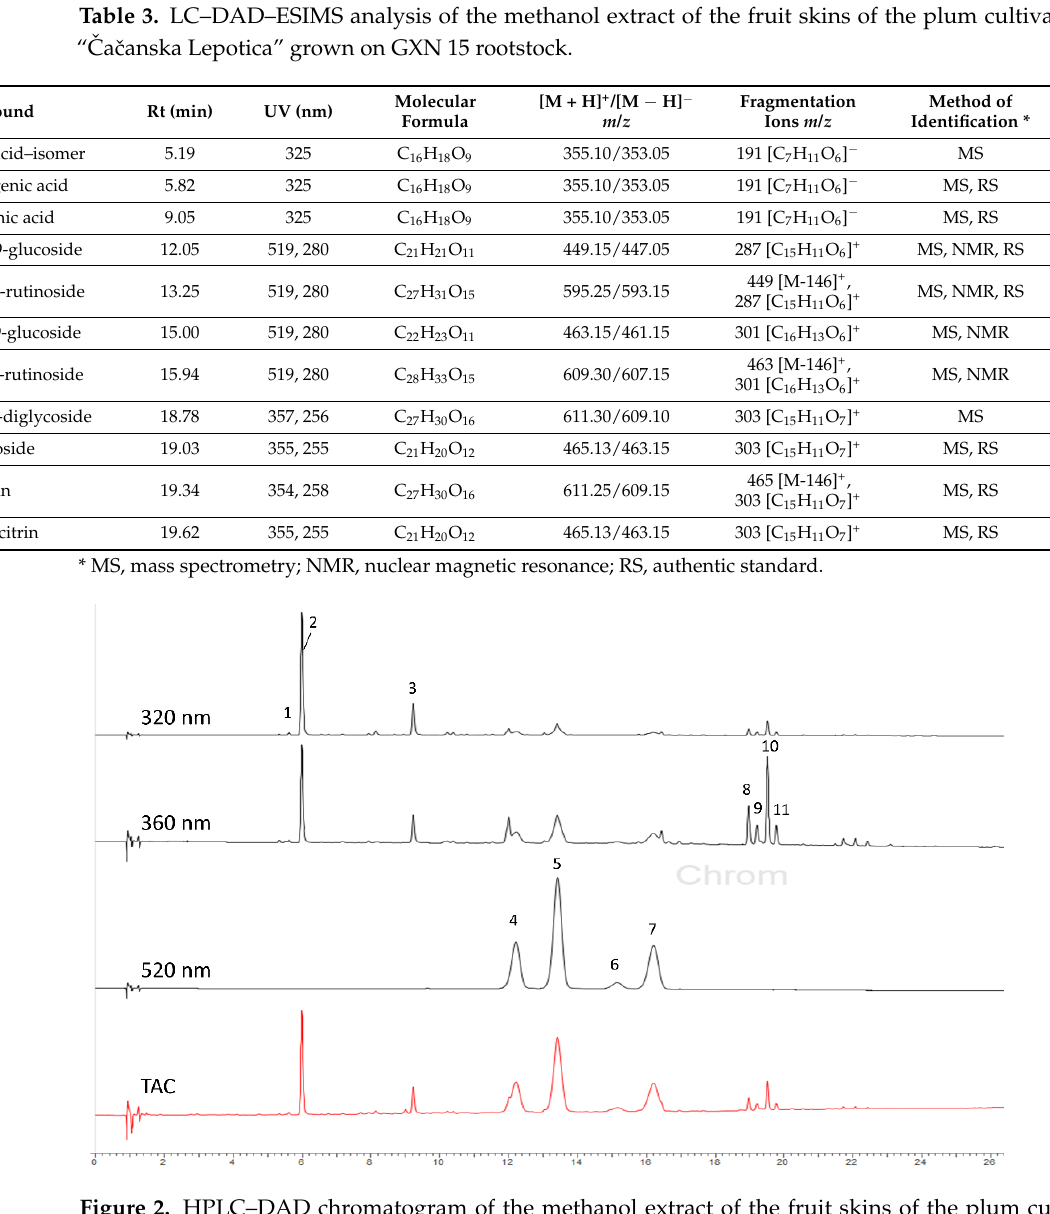
Table 3. LC–DAD–ESIMS analysis of the methanol extract of the fruit skins of the plum cultivar “ Č a č anska Lepotica” grown on GXN 15 rootstock.